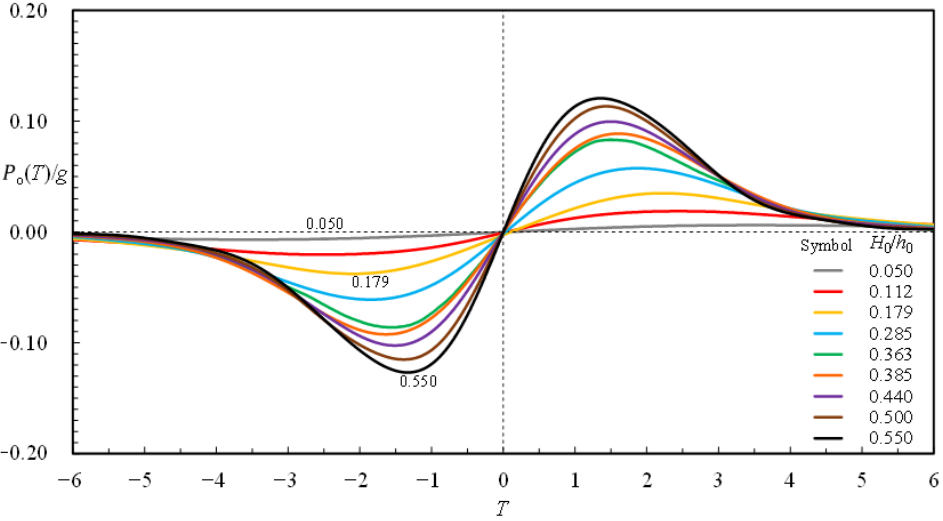
Figure 18. A comparison of temporal variations in the non-dimensional pressure gradient of the free stream for H 0 / h 0 = 0.050–0.550. stream for H 0 / h 0 =